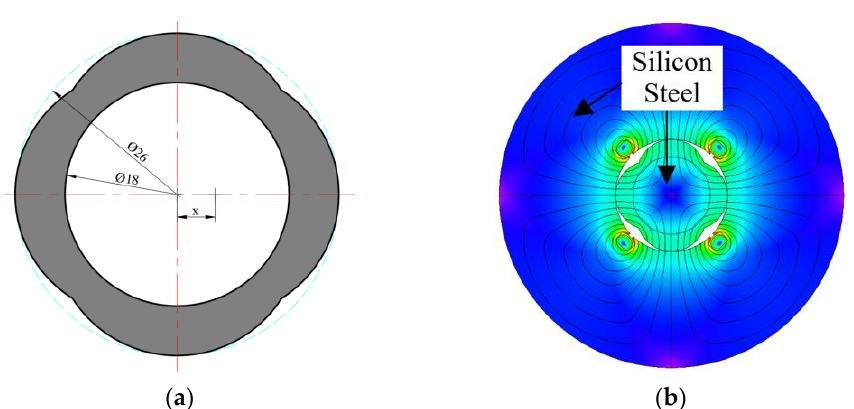
Figure 3. ( a ) Schematic diagram of eccentric pole cutting magnetic ring. ( b ) Magnetization simulation cloud chart.